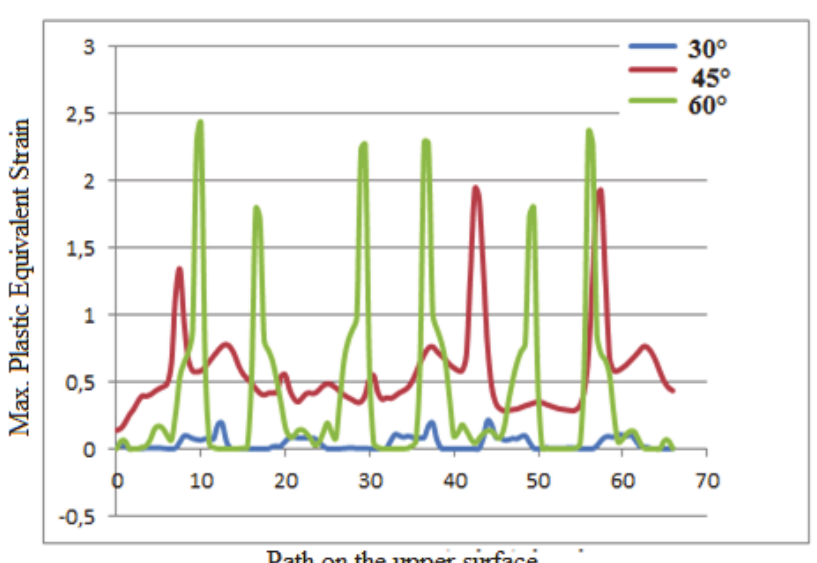
Figure 13: Evolution of the equivalent plastic strain for a path of the upper surface using different angles of grooves.